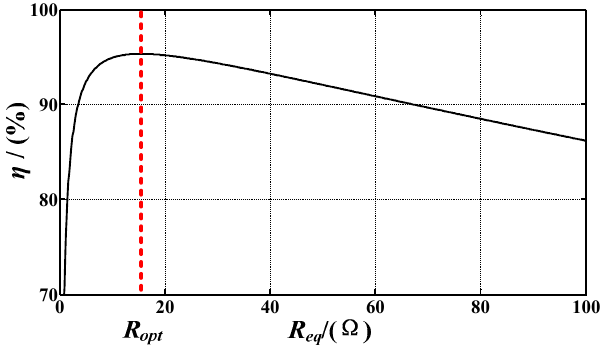
Figure 11. The relationship between η and R eq .